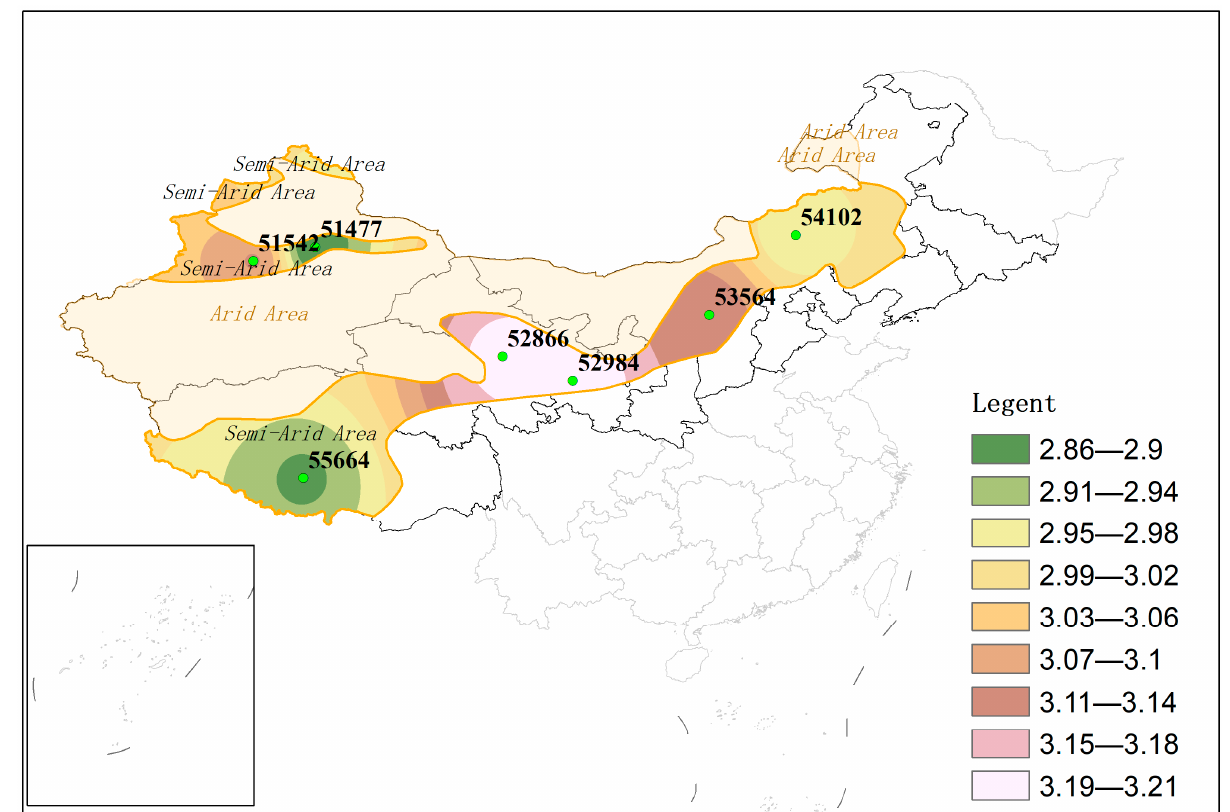
Figure 8. The spatial map of ET O estimated by the recommended model in 2019. Table 3. GPI value and ranking of the three ET O models.